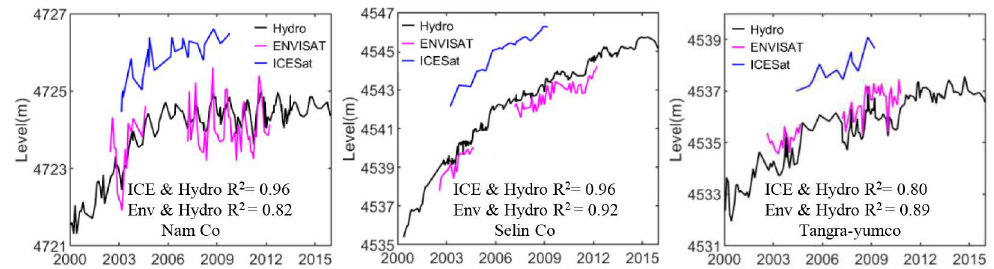
Figure 3. Comparisons among three di ff erent sources of lake level results collected in 2000–2015 for Nam Co, Selin Co, and